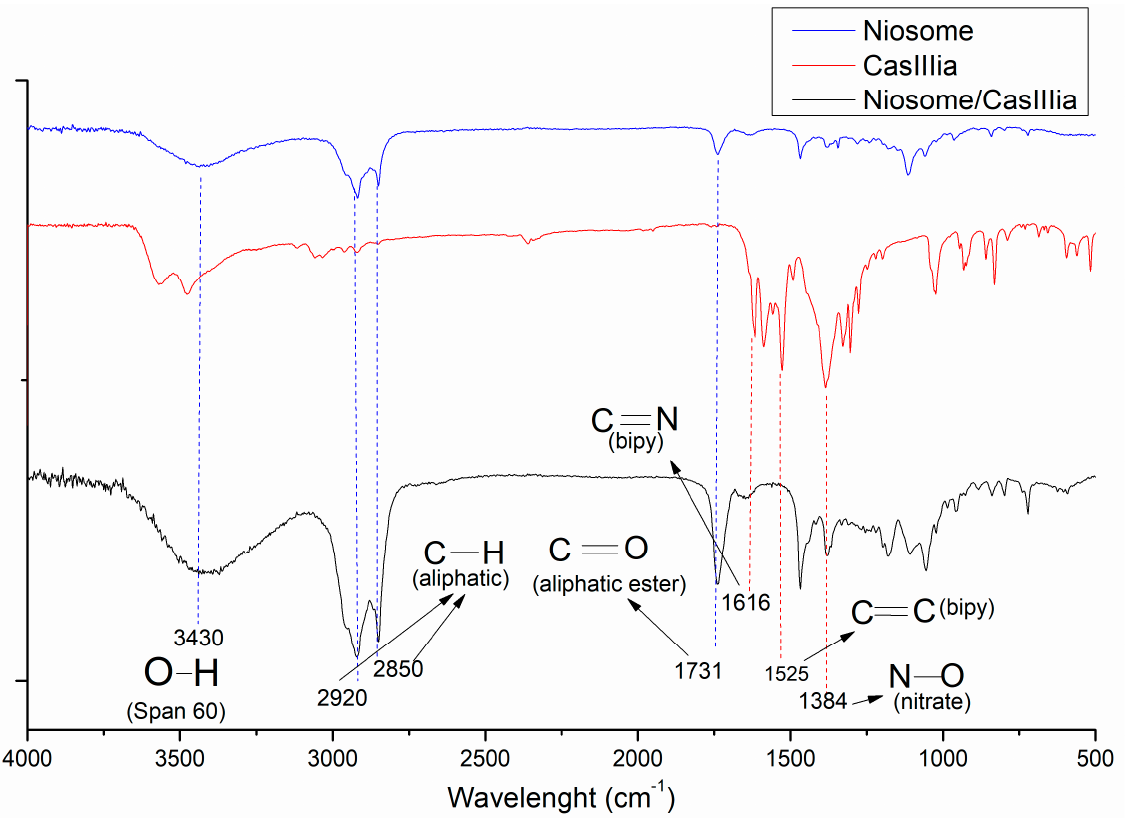
Figure 5. FTIR spectra of CasIII—ia (red line), niosome blank (blue line), and niosome with CasIII—ia (black line).